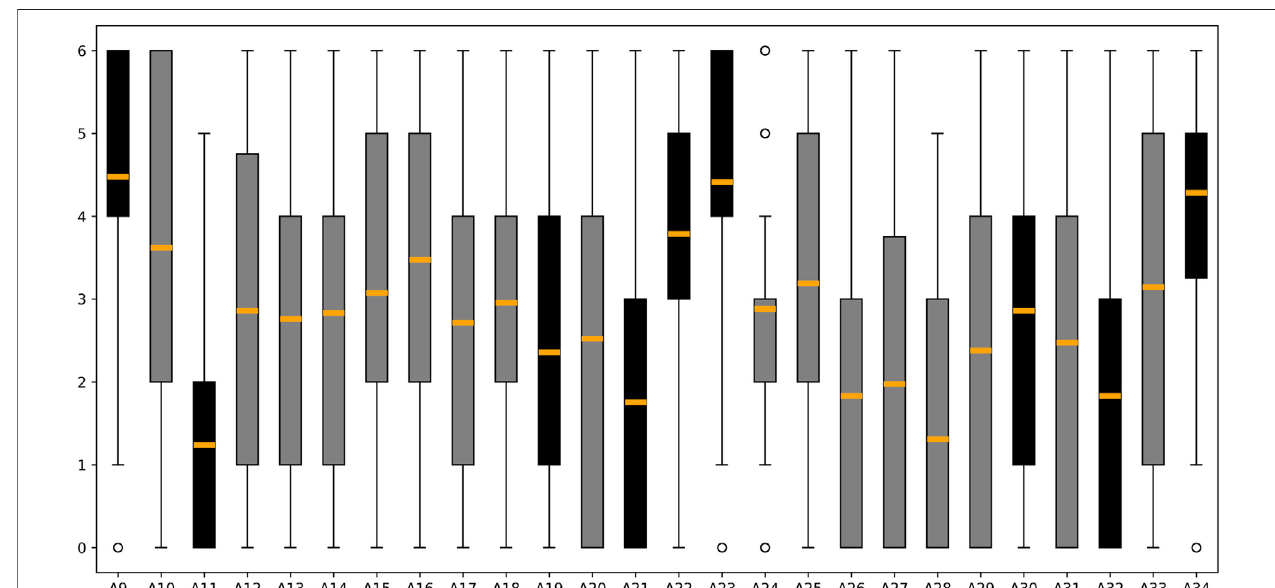
FIGURE 11 | Quantitative results of post-experiential questionnaires. Highlighted whiskers correspond to the highlighted assertions in Table 1 , and orange lines represent the means.